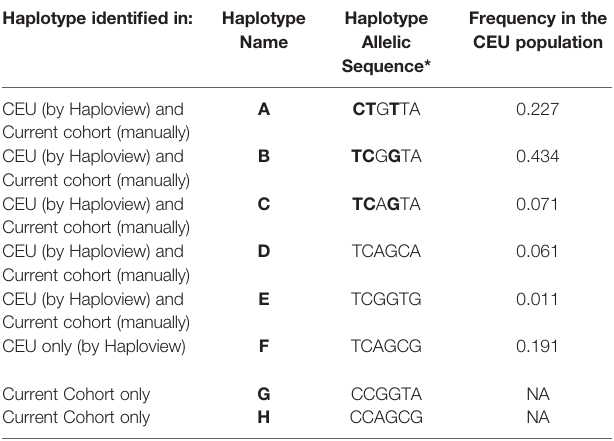
TABLE 3 | Major haplotypes identi fi ed in the CEU population using Haploview, and in our cohort using manual analysis. Haplotype identi fi ed in: